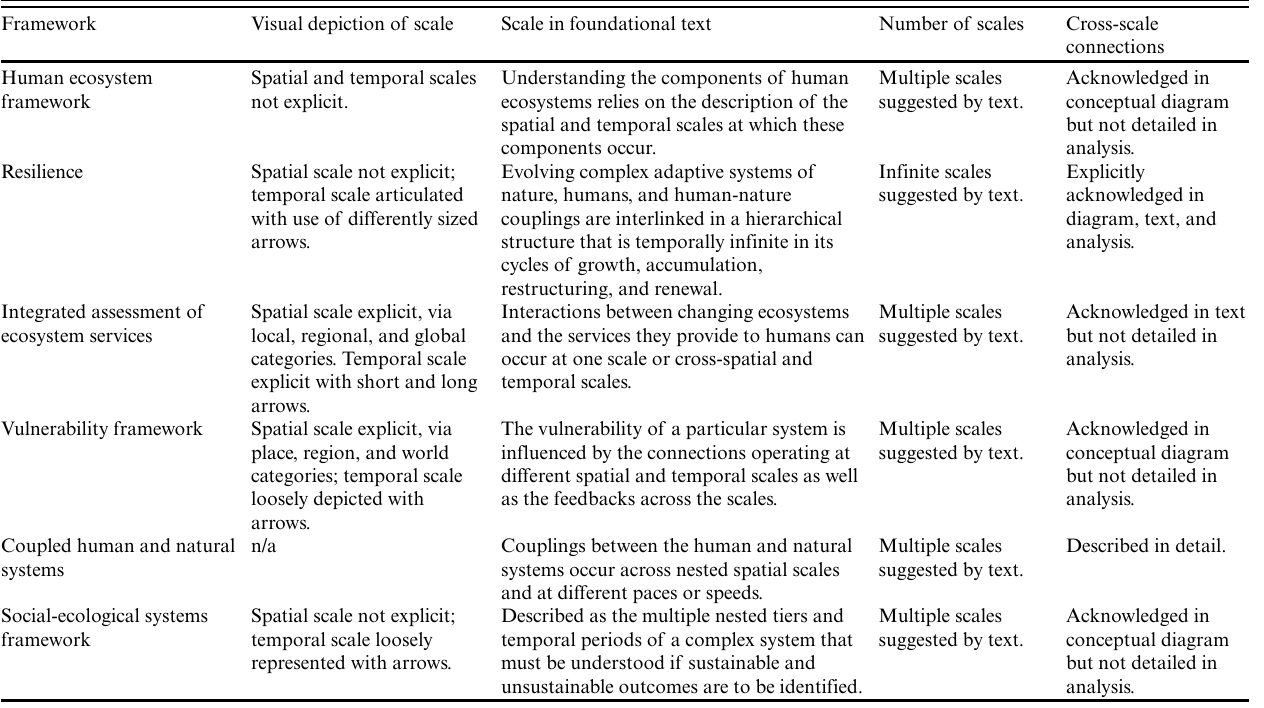
Table 4 . Comparing scale in selected socio-environmental (SE)